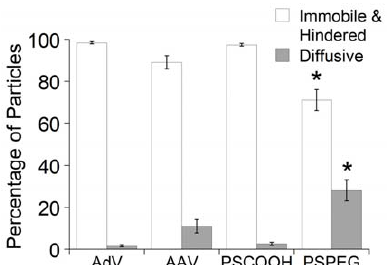
Figure 2. Averaged ensemble mean squared displacements , MSD . of viral vectors and synthetic particles with respect to time scale. Data represent n=5 independent experiments with , 100 particles tracked per experimental condition. Error bars represents standard error. *Statistically significant difference when compared with AAV5, AdV or PS (p ,